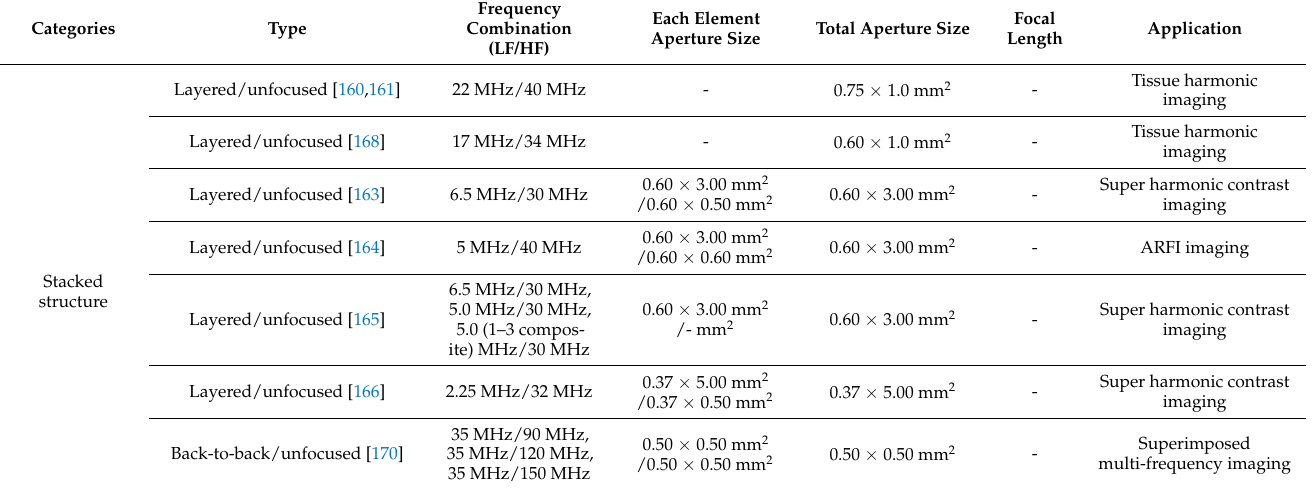
Table 3. Characteristics of multifrequency mechanical IVUS